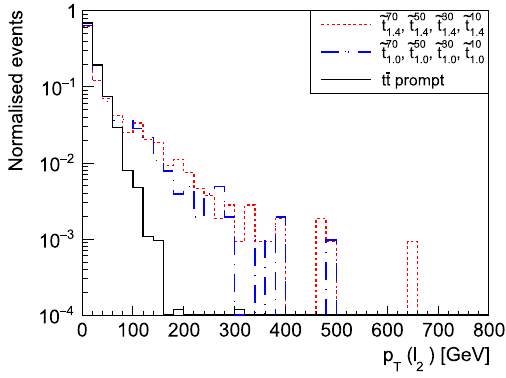
Fig. 58 Transverse momentum p T of the second leading lepton in the stop squark ˜ t case